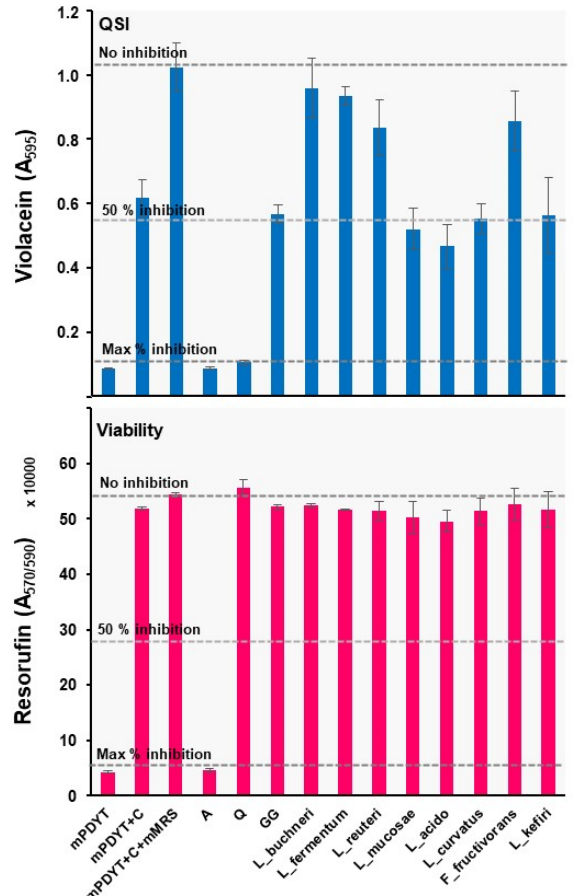
Figure 3. Anti-QS (blue) and bactericidal (pink) activities of the spent culture supernatants (10 µL) tested against ATCC31532. mPDYT, growth media; mPDYT+C, growth medium with ATCC31532; A, azithromycin; Q, quercetin. Error bars ± SD (n = 3–6). Z’ = 0.58; S/N = 7.20; S/B = 11.31. Grid lines, detected violacein levels with/without QS (Q) and bactericidal (A) inhibitors.